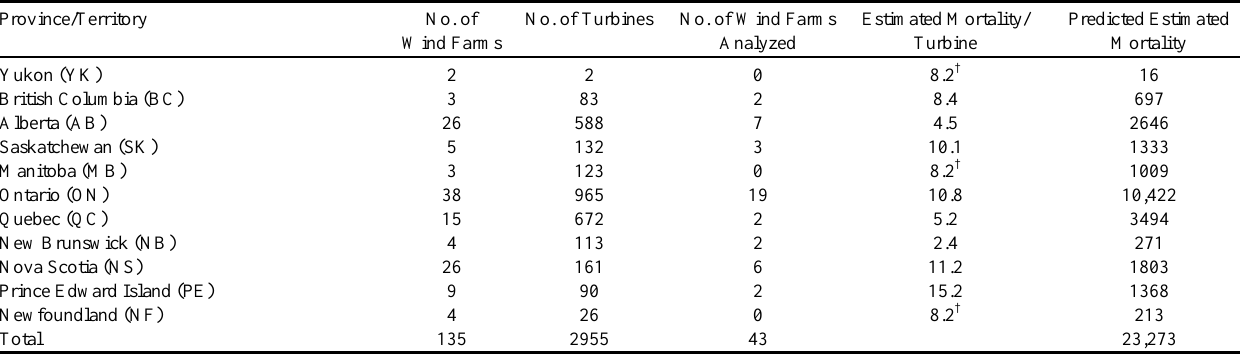
Table 1 . Estimated bird mortality per turbine from collisions at wind farms with available carcass search data, and estimated total mortality per province based on the number of installed